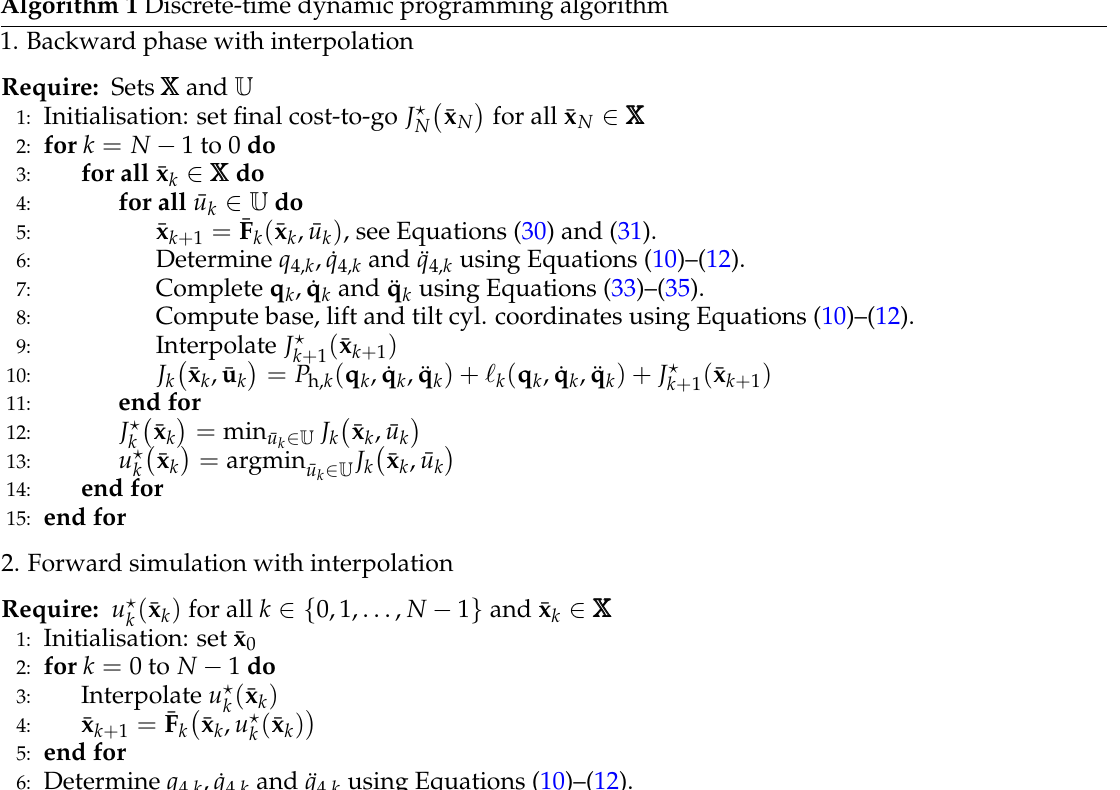
Algorithm 1 Discrete-time dynamic programming algorithm 1. Backward phase with